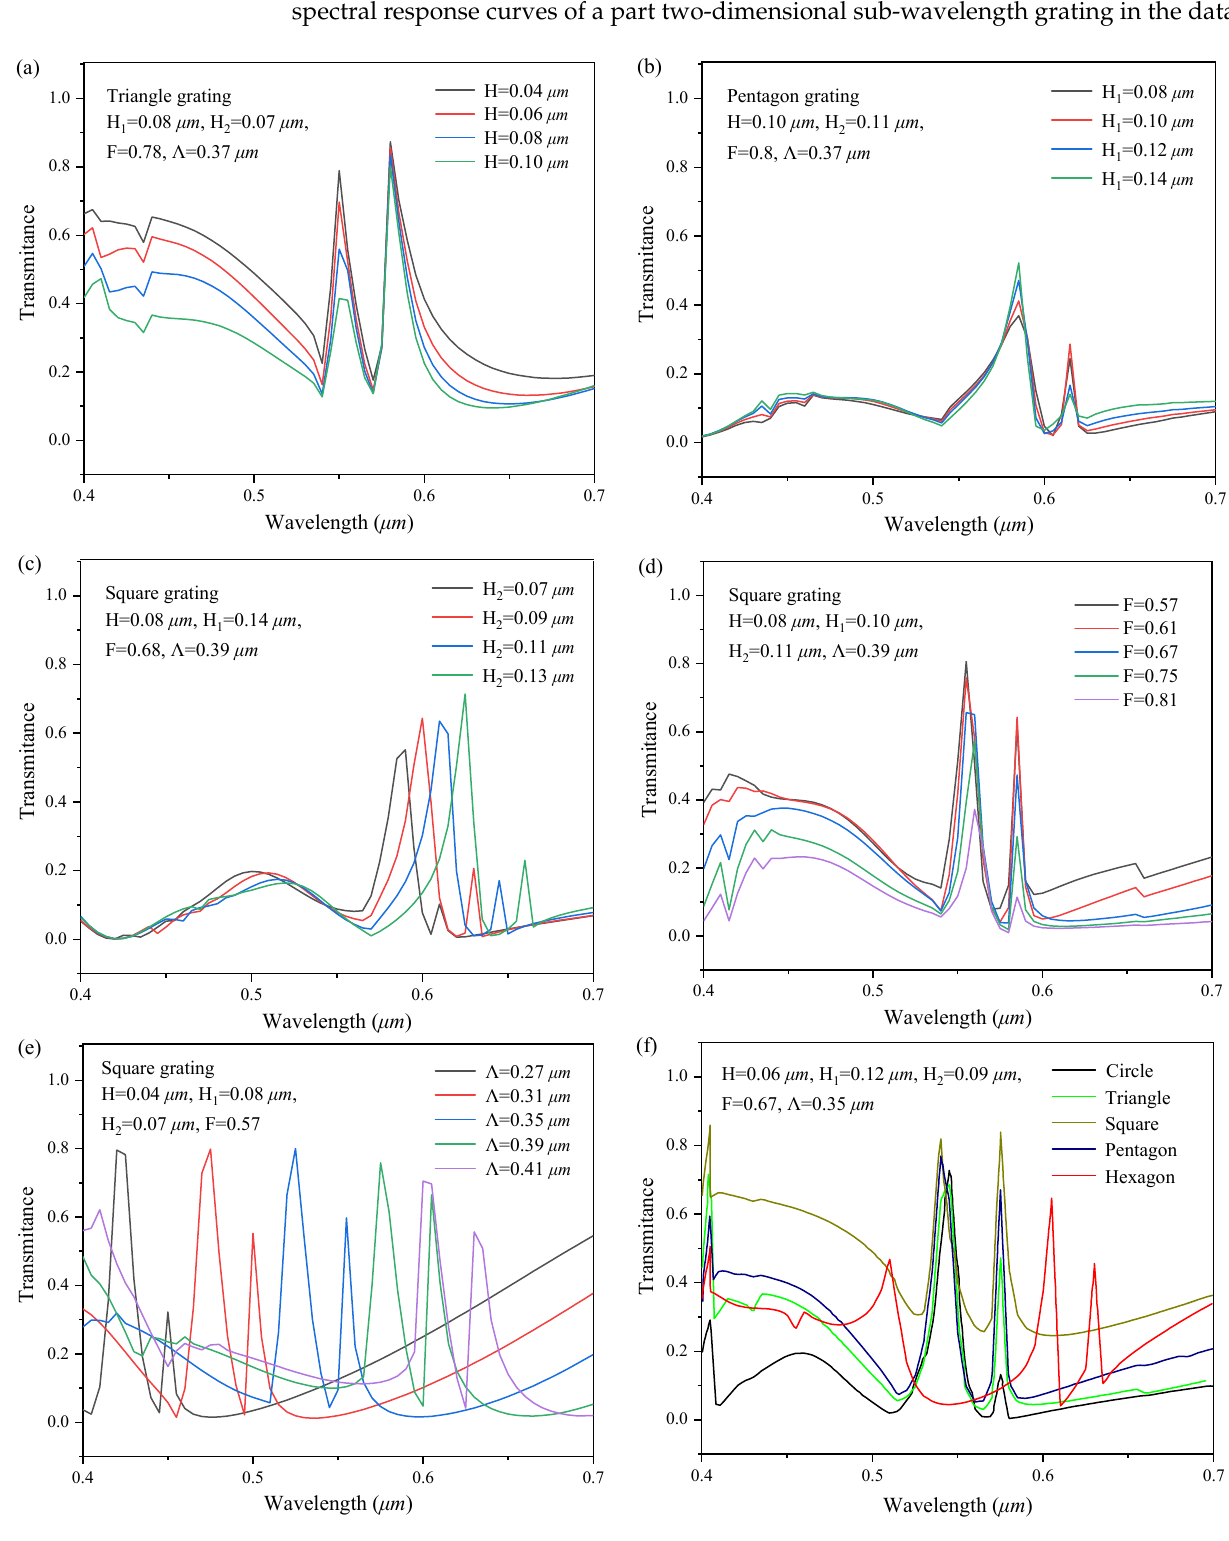
Figure 3. The spectral response curves of ( a ) triangle, ( b ) pentagon, ( c ) square with different H 2 , ( d ) square with different F, ( e ) square with different Λ , ( f ) different shapes with same parameters.